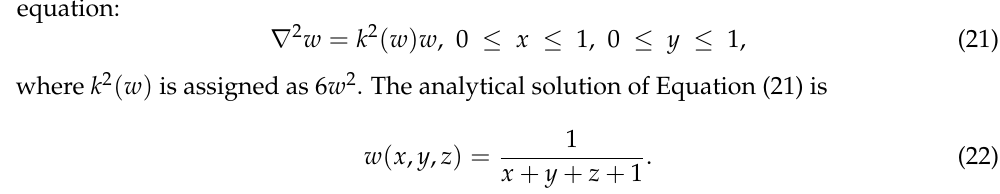
Figure 14. Potential distributions for a nonlinear Poisson problem: ( a ) numerical solution; ( b ) absolute errors.